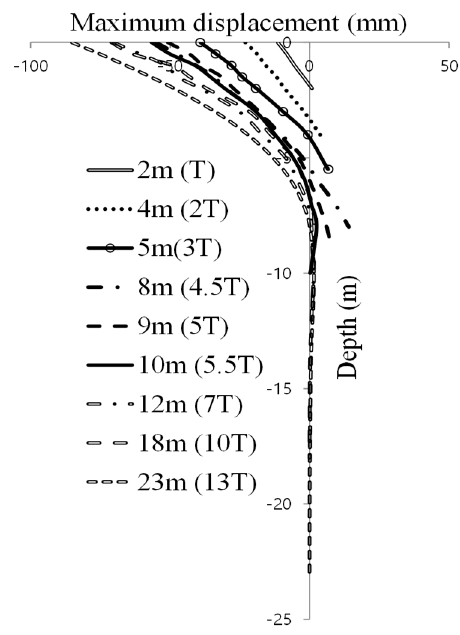
Figure 17. Maximum lateral pile displacements for various pile lengths (input acceleration: 0.13 g).